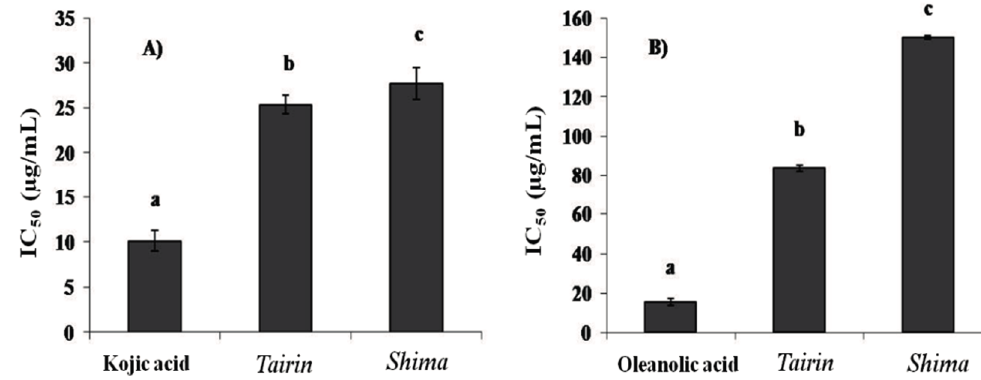
Figure 2. Tairin and shima essential oil (EO)-mediated tyrosinase ( A ) and hyaluronidase ( B ) inhibition. Values shown represent the mean ± standard error from three independent experiments. One-way ANOVA was used for the comparison of multiple group means, followed by the Duncan test ( p < 0.05). Letters with different superscripts indicate samples that are significantly different ( p < 0.05) from each other. IC, inhibitory